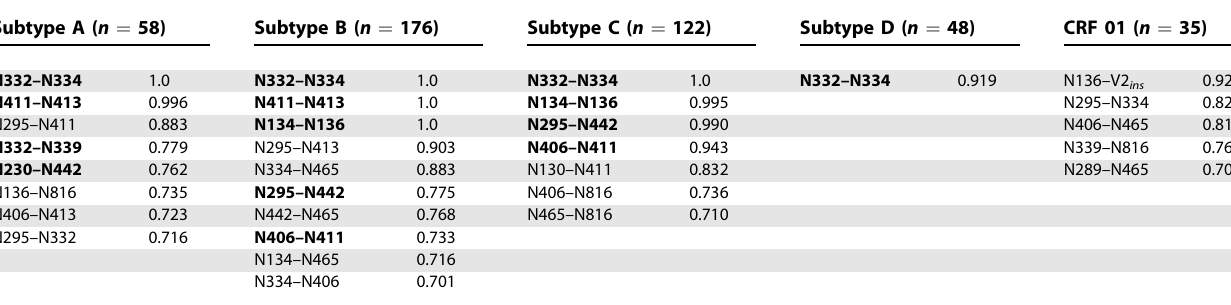
Table 2. Posterior Probabilities of Undirected Arcs in Subtype-Specific